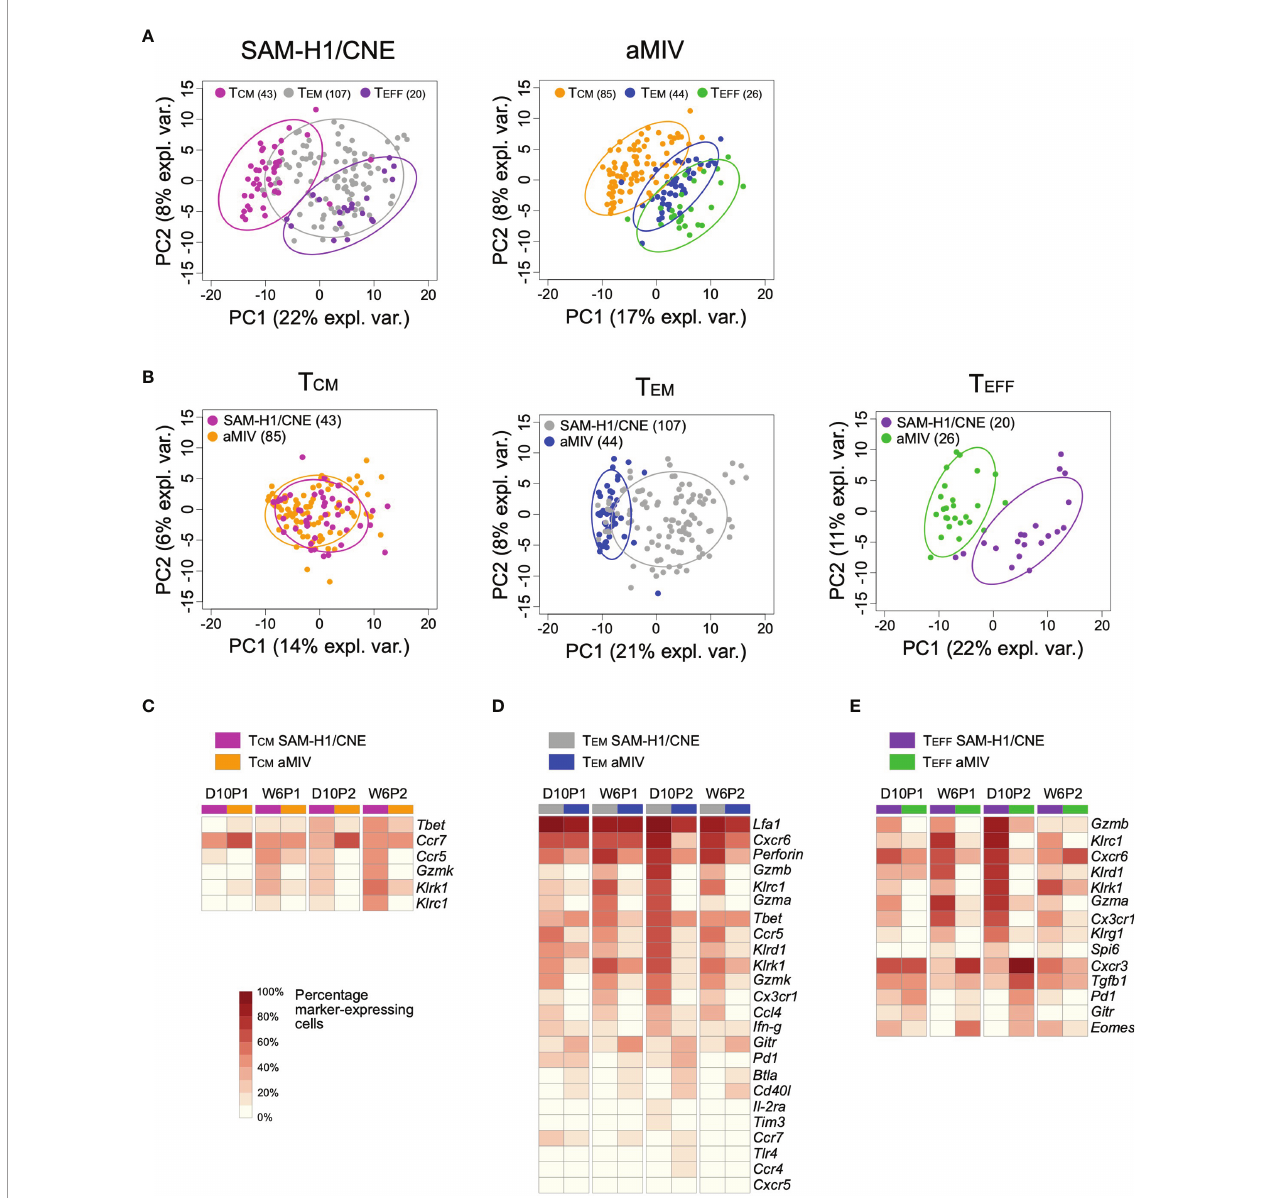
FIGURE 6 | Transcriptome pro fi les of pent+CD8+ T CM , T EM and T EFF cell subpopulations induced by SAM-H1/CNE and aMIV at D10P2. Representation of individual cells on the fi rst two principal components for the T CM , T EM and T EFF cells in response to either SAM-H1/CNE or aMIV. (A) Comparison of the three cell populations. (B) Comparison of each speci fi c cell population. (C – E) Heatmap representing the percentage of cells expressing each speci fi c gene within the T CM , T EM and T EFF cells. Only gene showing a signi fi cant difference (adjusted Fisher ’ s exact test p -value ≤ 0.05) between SAM-H1/CNE and aMIV, for the D10P2 time point, are represented. Differences between groups were tested by comparing the frequencies of cells expressing each speci fi c marker through the Fisher ’ s exact test. p -values were corrected for multiple testing using the Benjamini-Hochberg